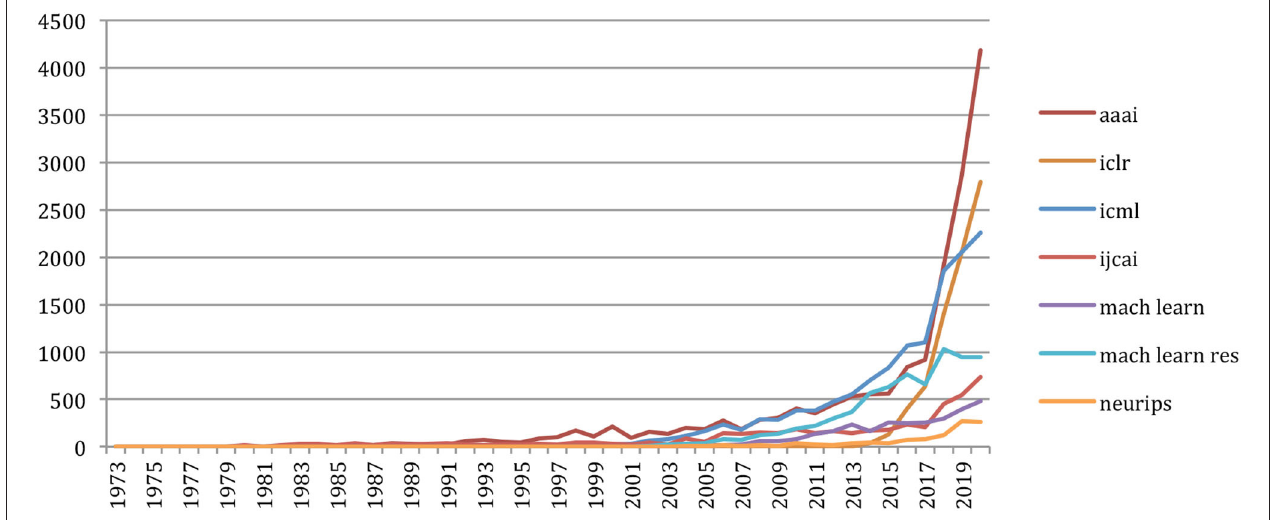
FIGURE 30 | Number of references related to AI, neural networks, and machine-learning sources external to